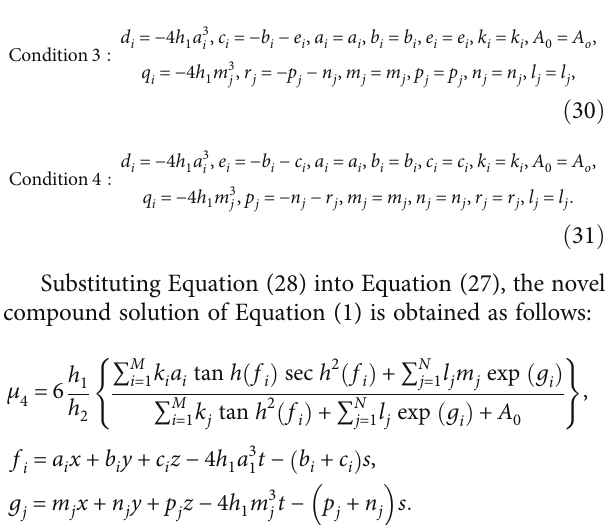
= h = b = c = m = p = k = k = k = l = l = 1, b 1 2 2 3 1 1 2 3 1 2 1